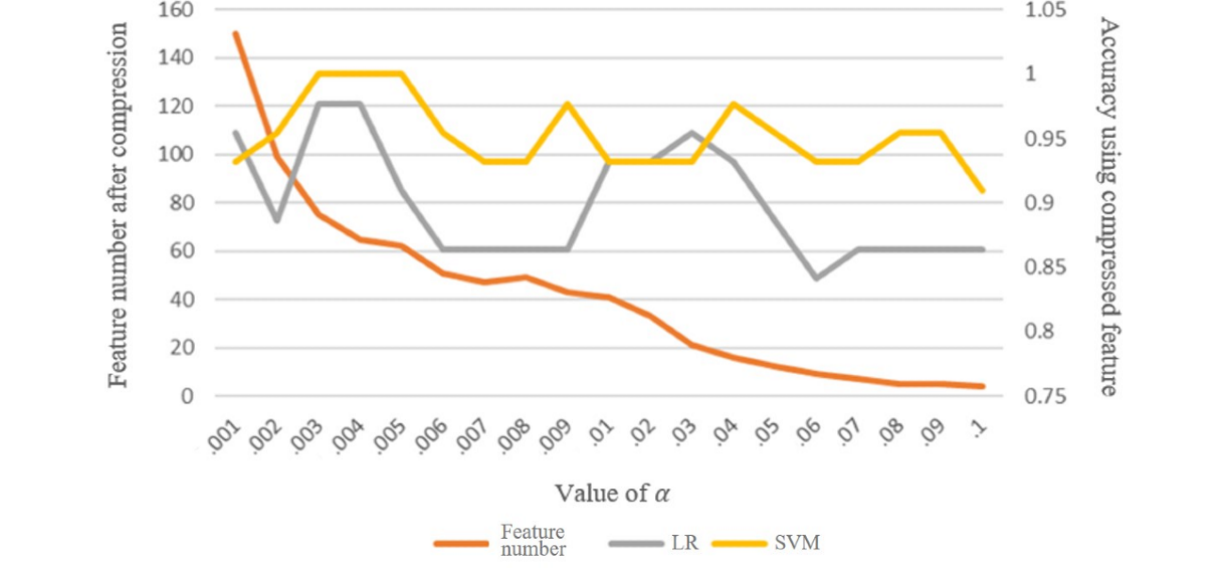
Number of key points that reached significanceFeature name